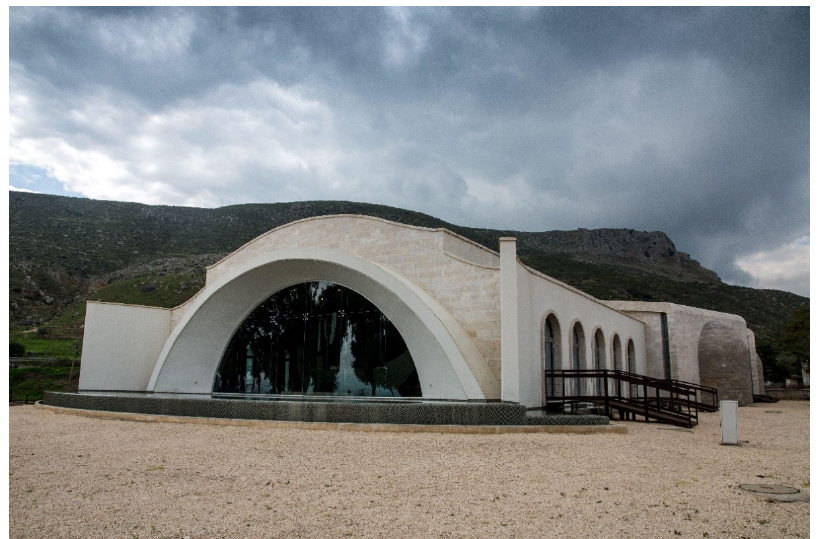
Figure 2. East Façade, Duc in Altum Worship Center, 2014 (photo: Ilan Amihai, Alamy Stock Photo).